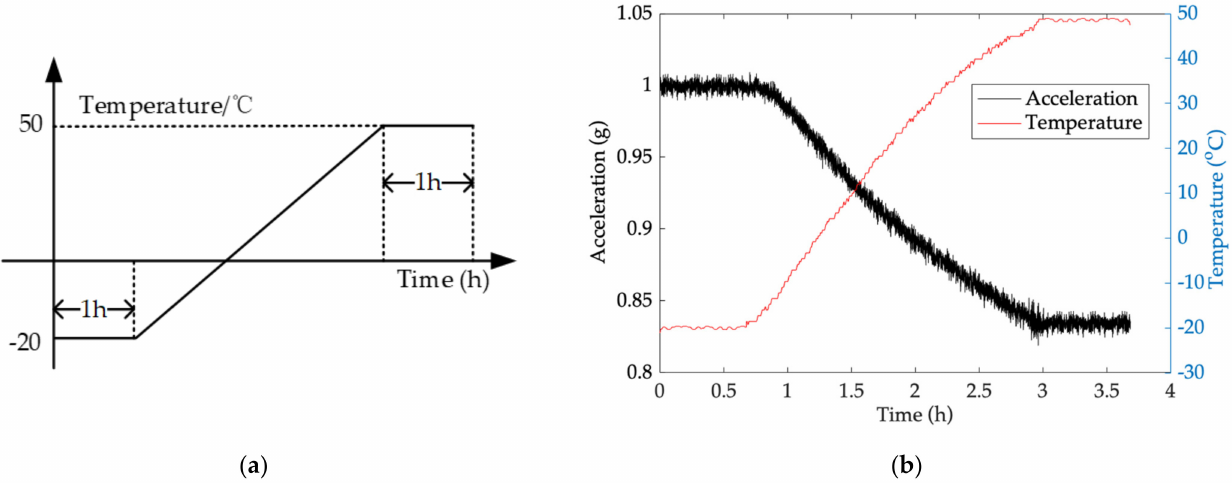
Figure 6. Flow chart of temperature experiment and the test results. ( a ) Test flow; ( b ) the test